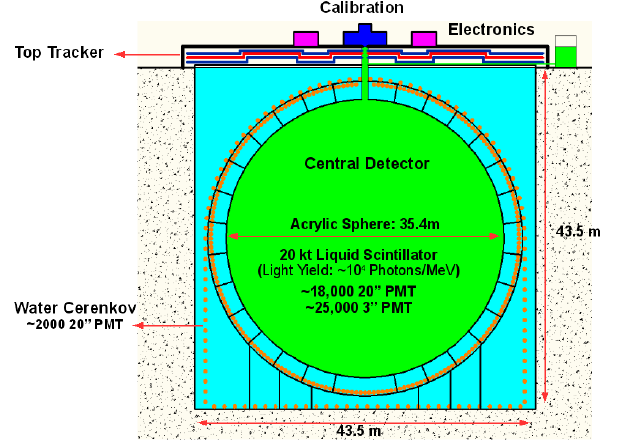
Figure 1. Schematic view of the JUNO detector